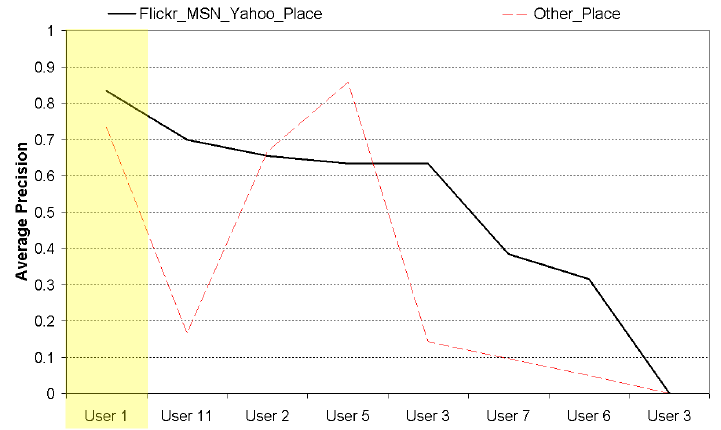
Figure 15. Performance of final recommended system on “place-specific”